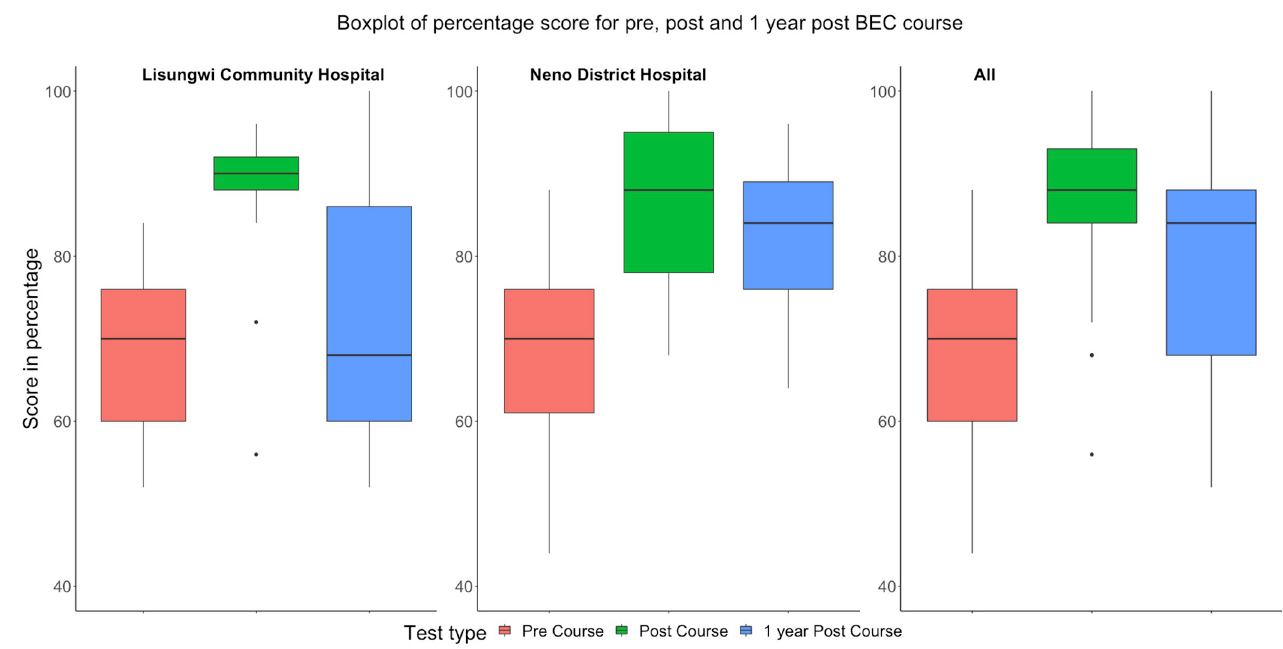
Fig 2. Box Plot of scores (in percentage) for pre-course, post-course and one-year post-course after the BEC course.